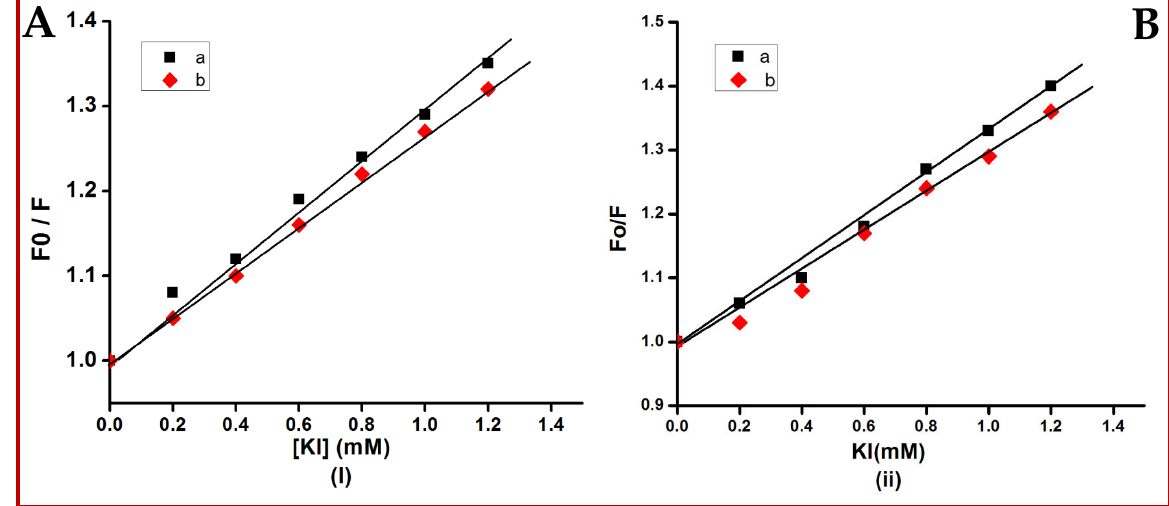
Figure 2: Stern – Volmer quenching plots of compounds 3a (I) and 3b (II) in the (a) absence and (b) presence of